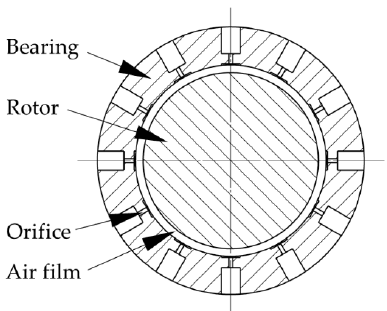
Figure 4. Schematic diagram of the radial section of the orifice throttling aerostatic spindle.